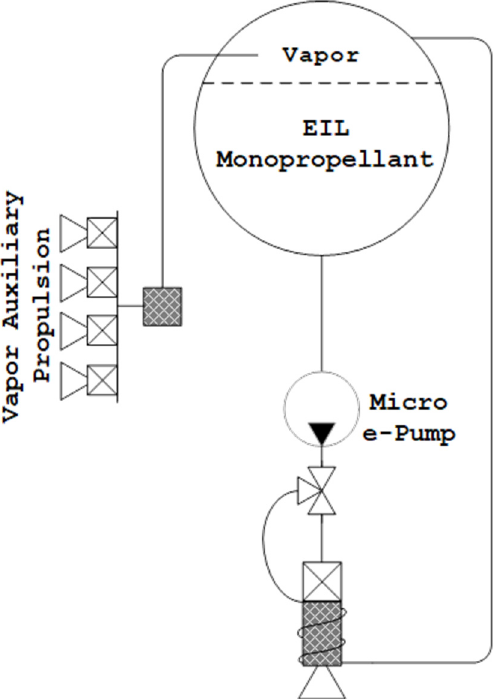
Figure 6. MIMPS-G propulsion system schematic diagram (including the optional auxiliary vapor propulsion in multimode architecture).